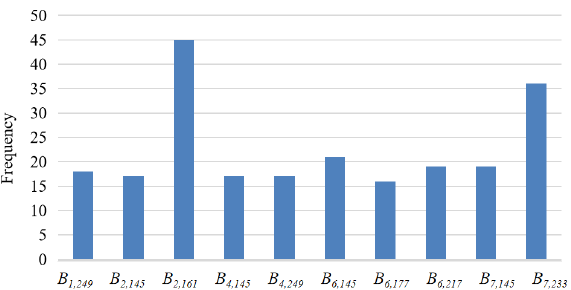
Figure 11. The frequency of the top 10 bands used in the GP methods learning the fixed and flexible numbers of features. numbers of